Question: In a single sentence, describe what this figure presents.
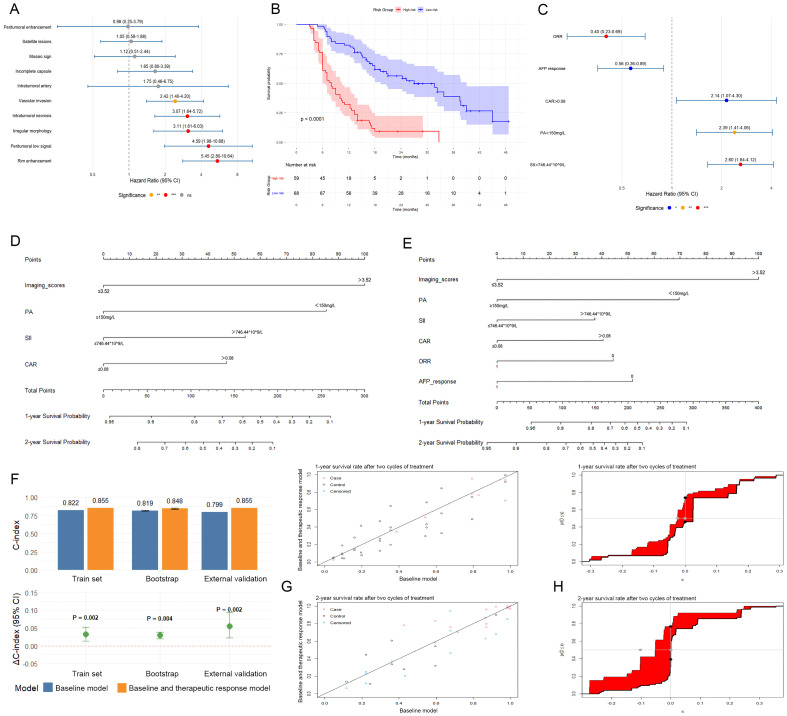
Answer: Features selection and nomogram construction. (A) Multivariate Cox analysis of imaging features forest plot; (B) Overall survival curve of risk stratification in imaging score (the optimal cut-off value of 3.52); (C) Multivariate Cox analysis of clinical features (after LASSO regression) forest plot; (D) Construction of the baseline nomogram model including baseline features; (E) Construction of the integrated nomogram model including baseline features and initial therapeutic response; (F) C-index comparison of both models; (G) Scatter diagram of continuous net reclassification index for 1-year and 2-year survival rates (more ‘Case’ above the diagonal or more ‘Control’ below the diagonal indicated that the integrated model improved over the baseline model); (H) Integrated discrimination improvement classification chart for 1-year and 2-year survival rates (a large red area indicated the integrated model improved over the baseline model). HR, hazard ratio; PA, prealbumin; SII, systemic Immune Inflammation index; CAR, C-reactive protein to albumin ratio; ORR, objective response rate; AFP, alpha-fetoprotein.